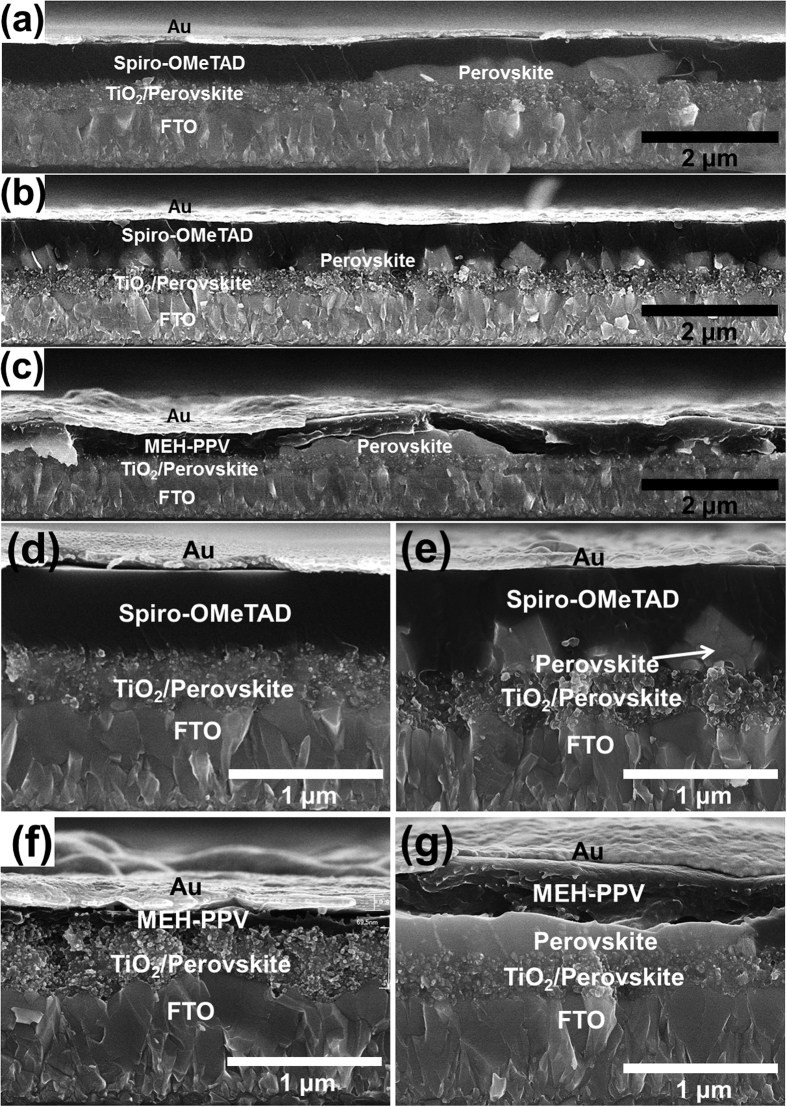
Cross-sectional SEM images of the layers observed in perovskite solar cells fabricated by the (a,d) one-step method of preparing CH3NH3PbI3−xClx and (b,e) two-step method of preparing CH3NH3PbI3 (tetragonal structure) with Spiro-OMeTAD (15 mg mL−1), (c,g) MEH-PPV (10 mg mL−1), and (f) MEH-PPV (5 mg mL−1).